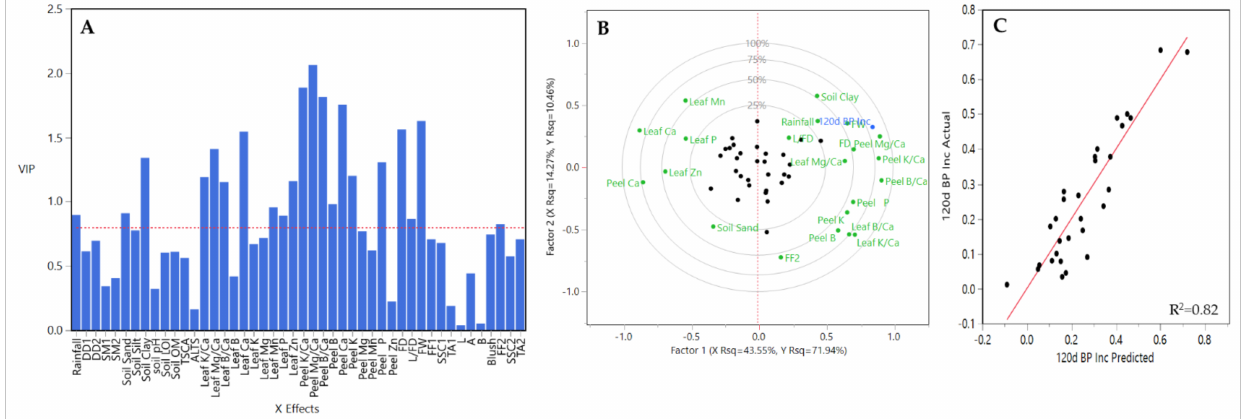
Figure 14. Results obtained from the partial least square (PLS) analysis between BP incidence at 120 DAH and the rest of variables evaluated all three years together for M.9 clone rootstocks in HV and CV. ( A ) Important X variables in the PLS model, ( B ) correlation loading plot, and ( C ) observed values versus PLSR-predicted values for BP. Abbreviations: ALTS: average length terminal shoot; DD1: degree days accumulated from 1st of January to harvest date; DD2: degree days accumulated from 60 days post-bloom; FD: fruit diameter; FF1: flesh firmness at harvest; FF2: flesh firmness after storage; FW: fruit weight; L: length; SSC1: soluble solids content at harvest; SSC2: soluble solids content after storage; SM1: average soil moisture 12 weeks prior to harvest; SM2: average soil moisture from 1st of January to harvest date; TA1: titratable acidity at harvest; TA2: titratable acidity after storage; TCSA: trunk cross-sectional